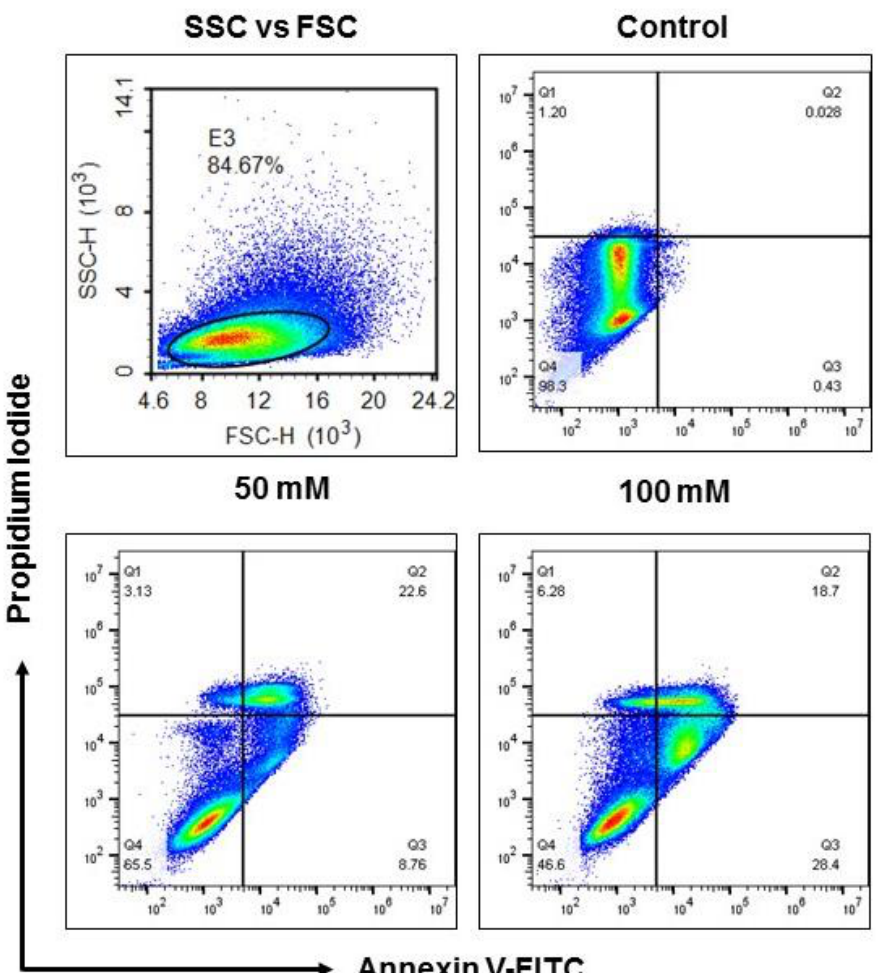
Figure 2. EtOH treatment reduced BV-2 cell viability in a dose-dependent manner. BV-2 cells were treated with 50 and 100 mM of EtOH at 72 h and cell viability was tested. Cells were washed and labeled with Annexin V-FITC and PI to discriminate apoptotic and healthy cells. For this experiment, live cells (E3: 84.67%) were gated to determine the percentage of early (Q3), late (Q2) and apoptotic (Q1) cells after EtOH exposure. Early apoptotic (Q3) and apoptotic (Q1) cell were higher when dosed with 100 mM; however, 50 mM showed higher a percentage of late apoptotic (Q2) cells. FSC: Forward Scatter; SSC: Side Scatter.